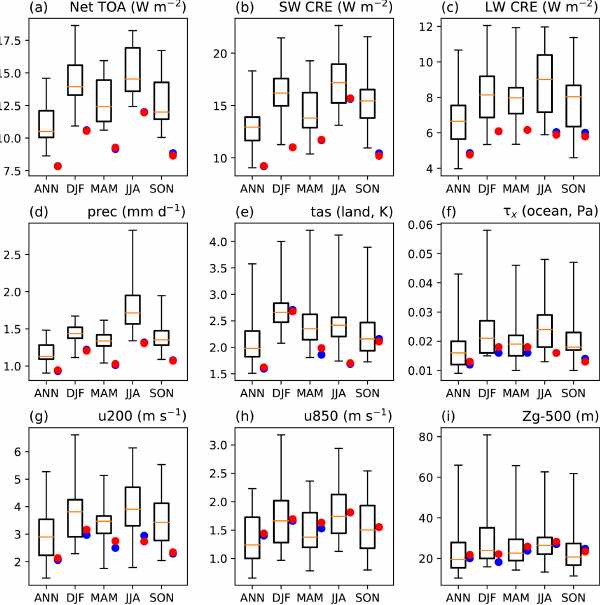
Figure 10. Comparison of global uncentered RMSE (1981–2005) of an ensemble of 30 Coupled Model Intercomparison Project Phase 5 (CMIP5) models (box and whiskers showing the 25th and 75th percentiles and minimum and maximum) with the two E3SM At- mospheric Model Intercomparison Project (AMIP) type simula- tions (O3v1: blue dots; O3v2: red dots). Spatial RMSE against ob- servations is computed for annual and seasonal averages with the PCMDI Metrics Package (Gleckler et al., 2016). Fields shown in- clude (a) top-of-atmosphere (TOA) net radiation, TOA (b) short- wave and (c) longwave cloud radiative effects, (d) precipitation, (e) surface air temperature over land, (f) zonal wind stress over ocean, (g) 200 and (h) 850hPa zonal wind, and (i) 500hPa geopo- tential height. CRE stands for cloud radiative effects, DJF stands for December–February, MAM stands for March–April, JJA stands for June–August, SON stands for September–November, and RMSE stands for root-mean-square